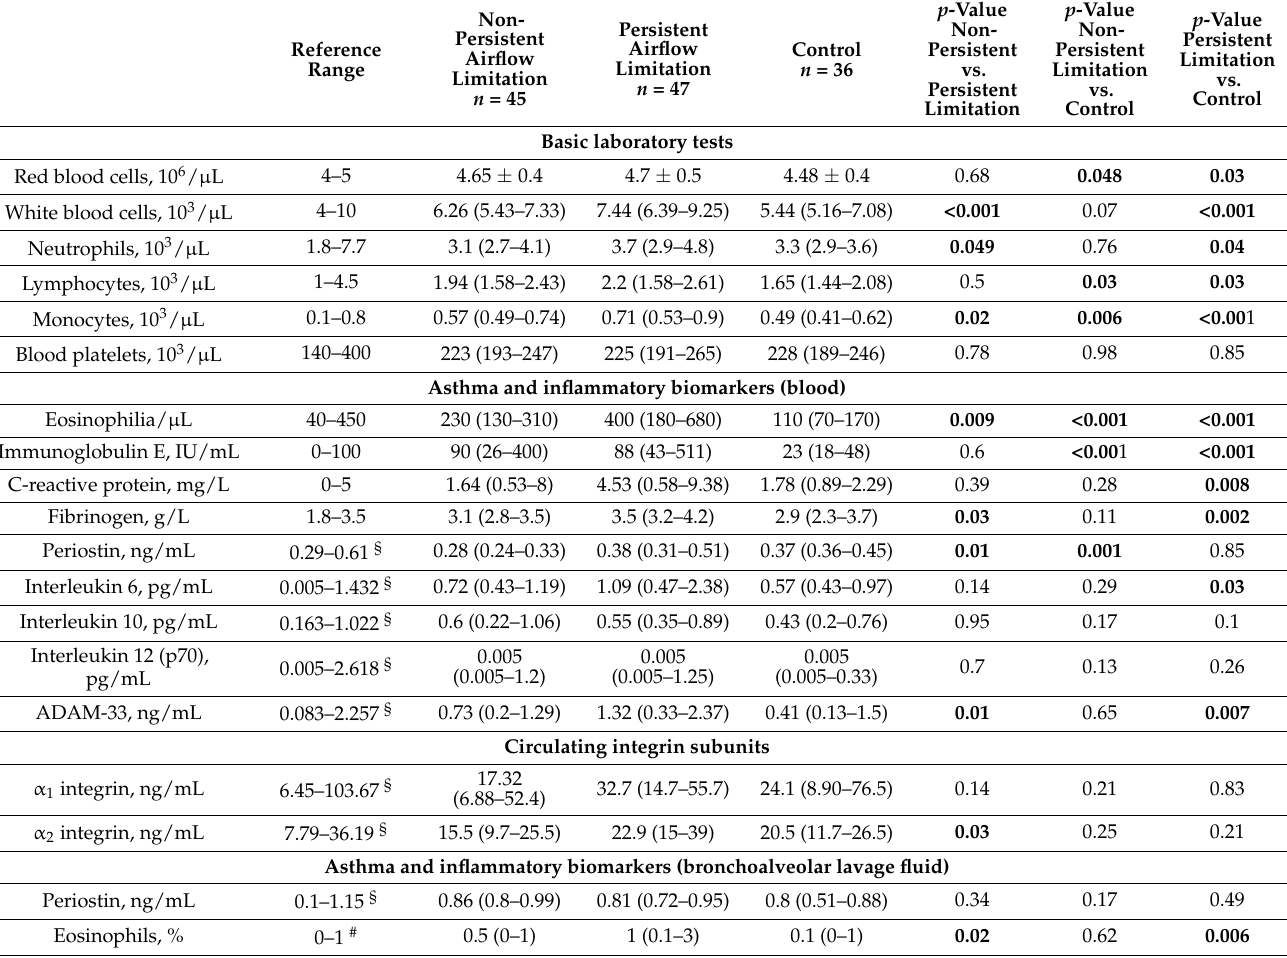
Table 2 footnote. Variables are presented as median and interquartile range or mean and standard deviation, as appropriate; § —reference range based on the 10th and 90th percentile values in the control group, # —reference according to the American Thoracic